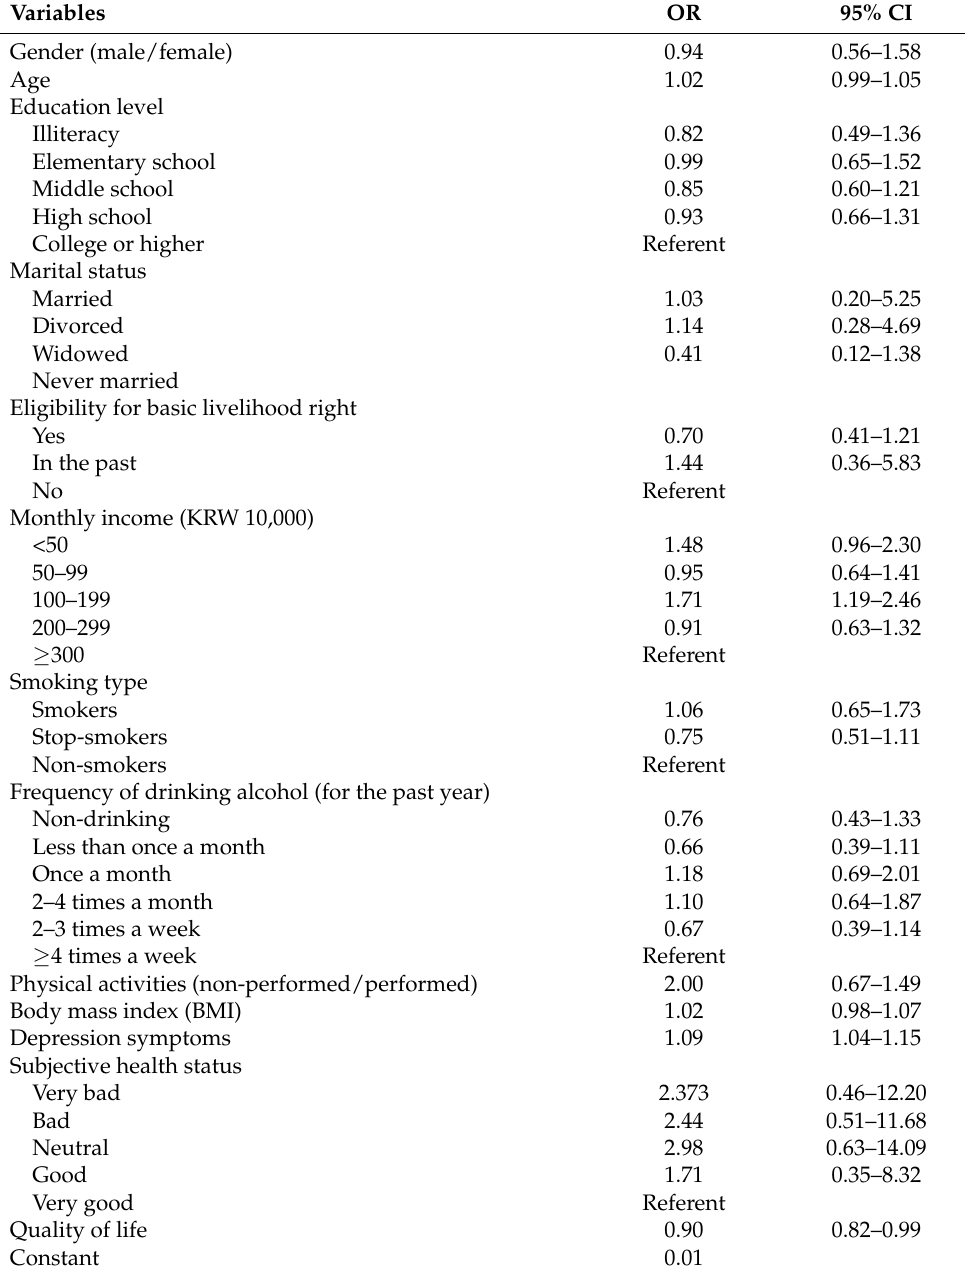
Table 3. Logistic regression model for associated factors of subjective